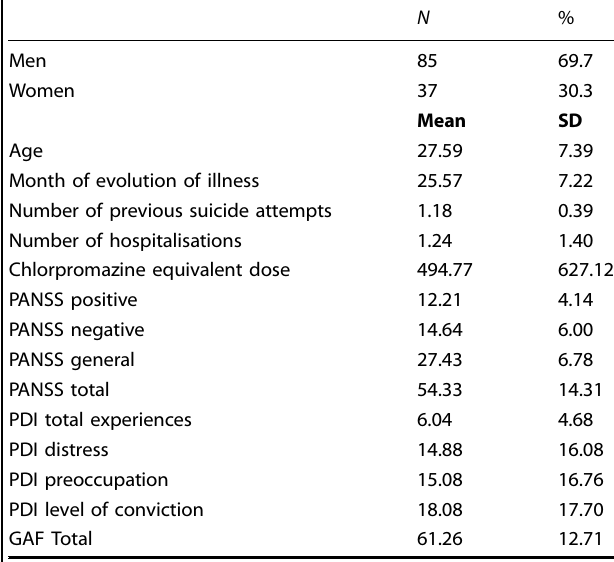
Table 1. Description of sociodemographic and clinical variables of the sample.